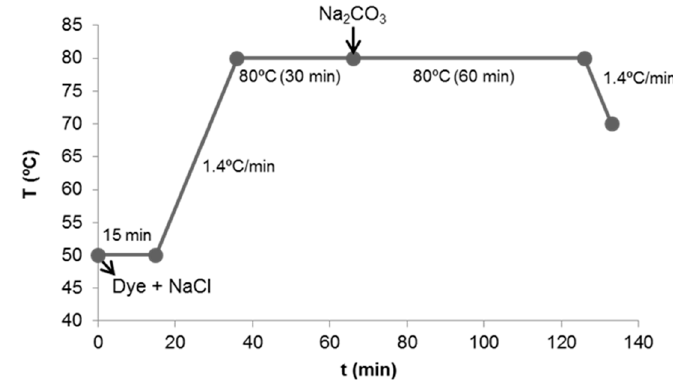
Figure 4. Dyeing procedure.